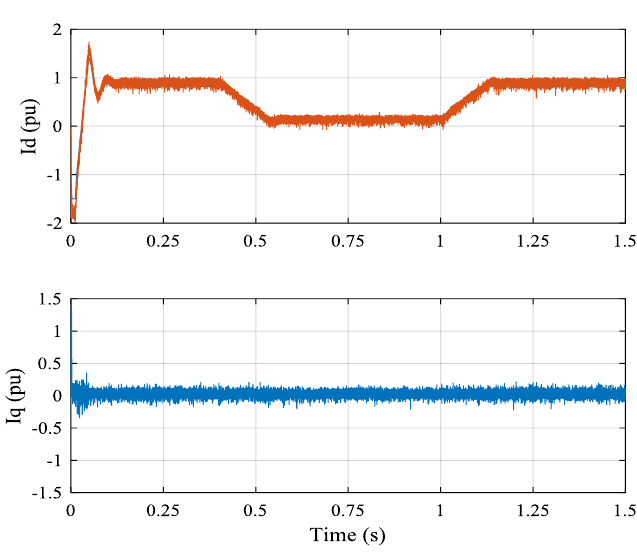
Figure 12. Per-unit currents in dq0 reference